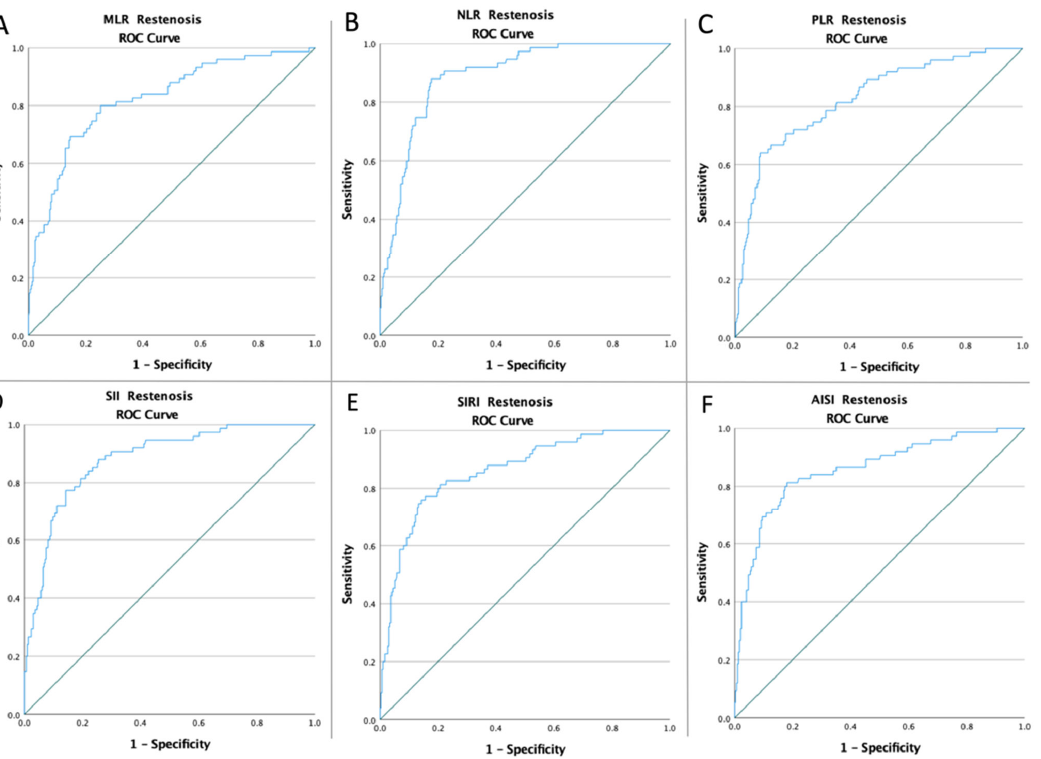
Figure 1. ROC curve analysis concerning Restenosis ( A ) for the MLR (AUC: 0.822; p < 0.0001), ( B ) for the NLR (AUC: 0.890; p < 0.0001), ( C ) for the PLR (AUC: 0.825; p < 0.0001), ( D ) for the SII (AUC: 0.880; p < 0.0001), ( E ) for the SIRI (AUC: 0.861; p < 0.0001), and ( F ) for the AISI (AUC: 0.857; p < 0.0001).